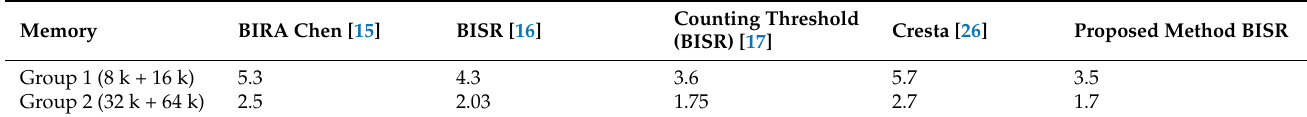
Table 11. Area overhead comparison.